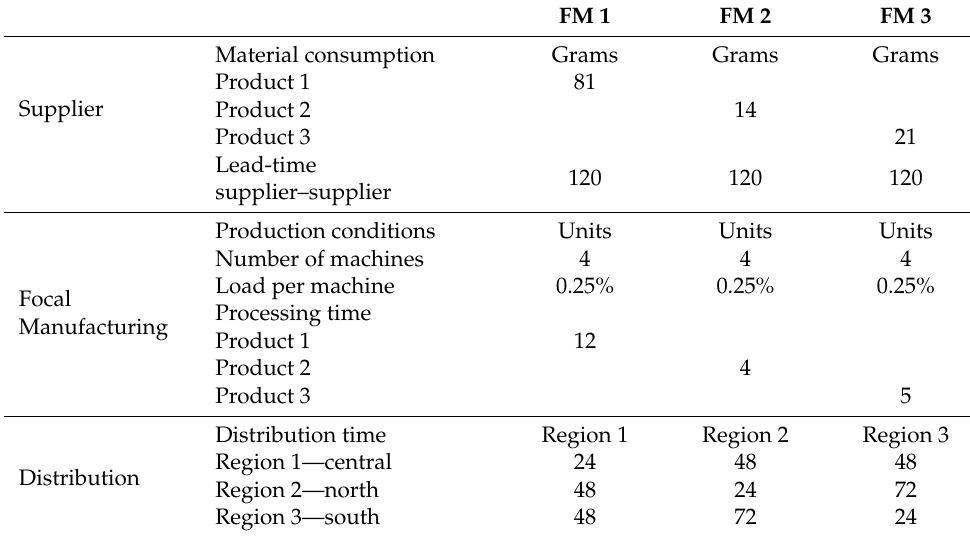
Table 4. Scenario 1